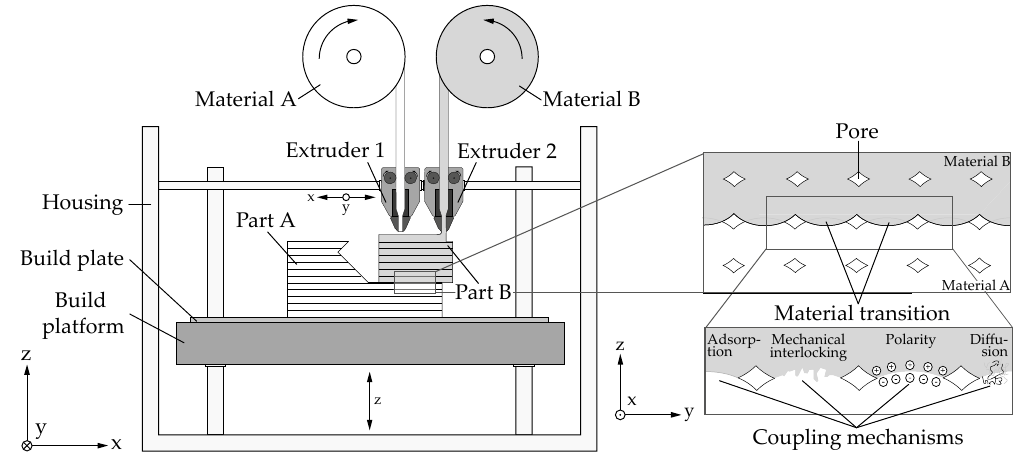
Figure 1. Schematic diagram of material extrusion principle and relevant adhesion mechanisms [11]